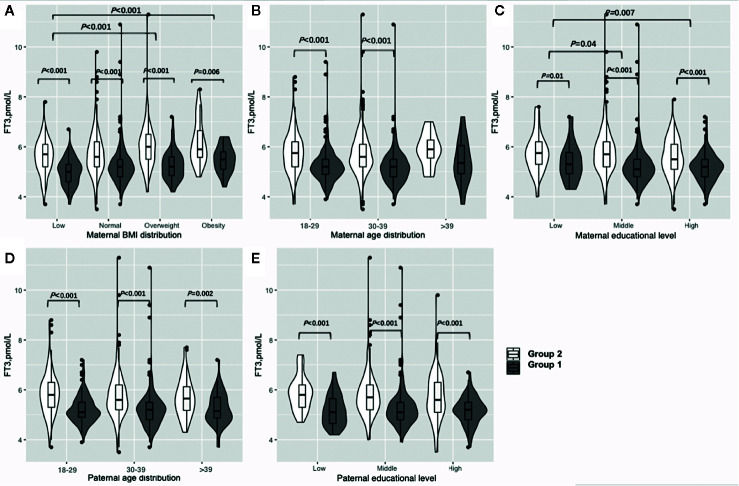
Subgroup analysis of FT3 concentration in the Propensity-Score-Matched Cohort. Figure shows the FT3 concentration in different subgroup of Group 1 and Group 2. The violin diagram is a combination of box plot and density plot. The thick black bar in the middle of the boxplot represents the median and quartile range, and the black line extending up and down represents the 95% confidence interval. The black dots on the black line indicate data values that exceed the 95% confidence interval. The outer contour indicates the distribution of the data. (A) Maternal BMI distribution. (B) Maternal age distribution. (C) Maternal educational level. (D) Paternal age distribution. (E) Paternal educational level.